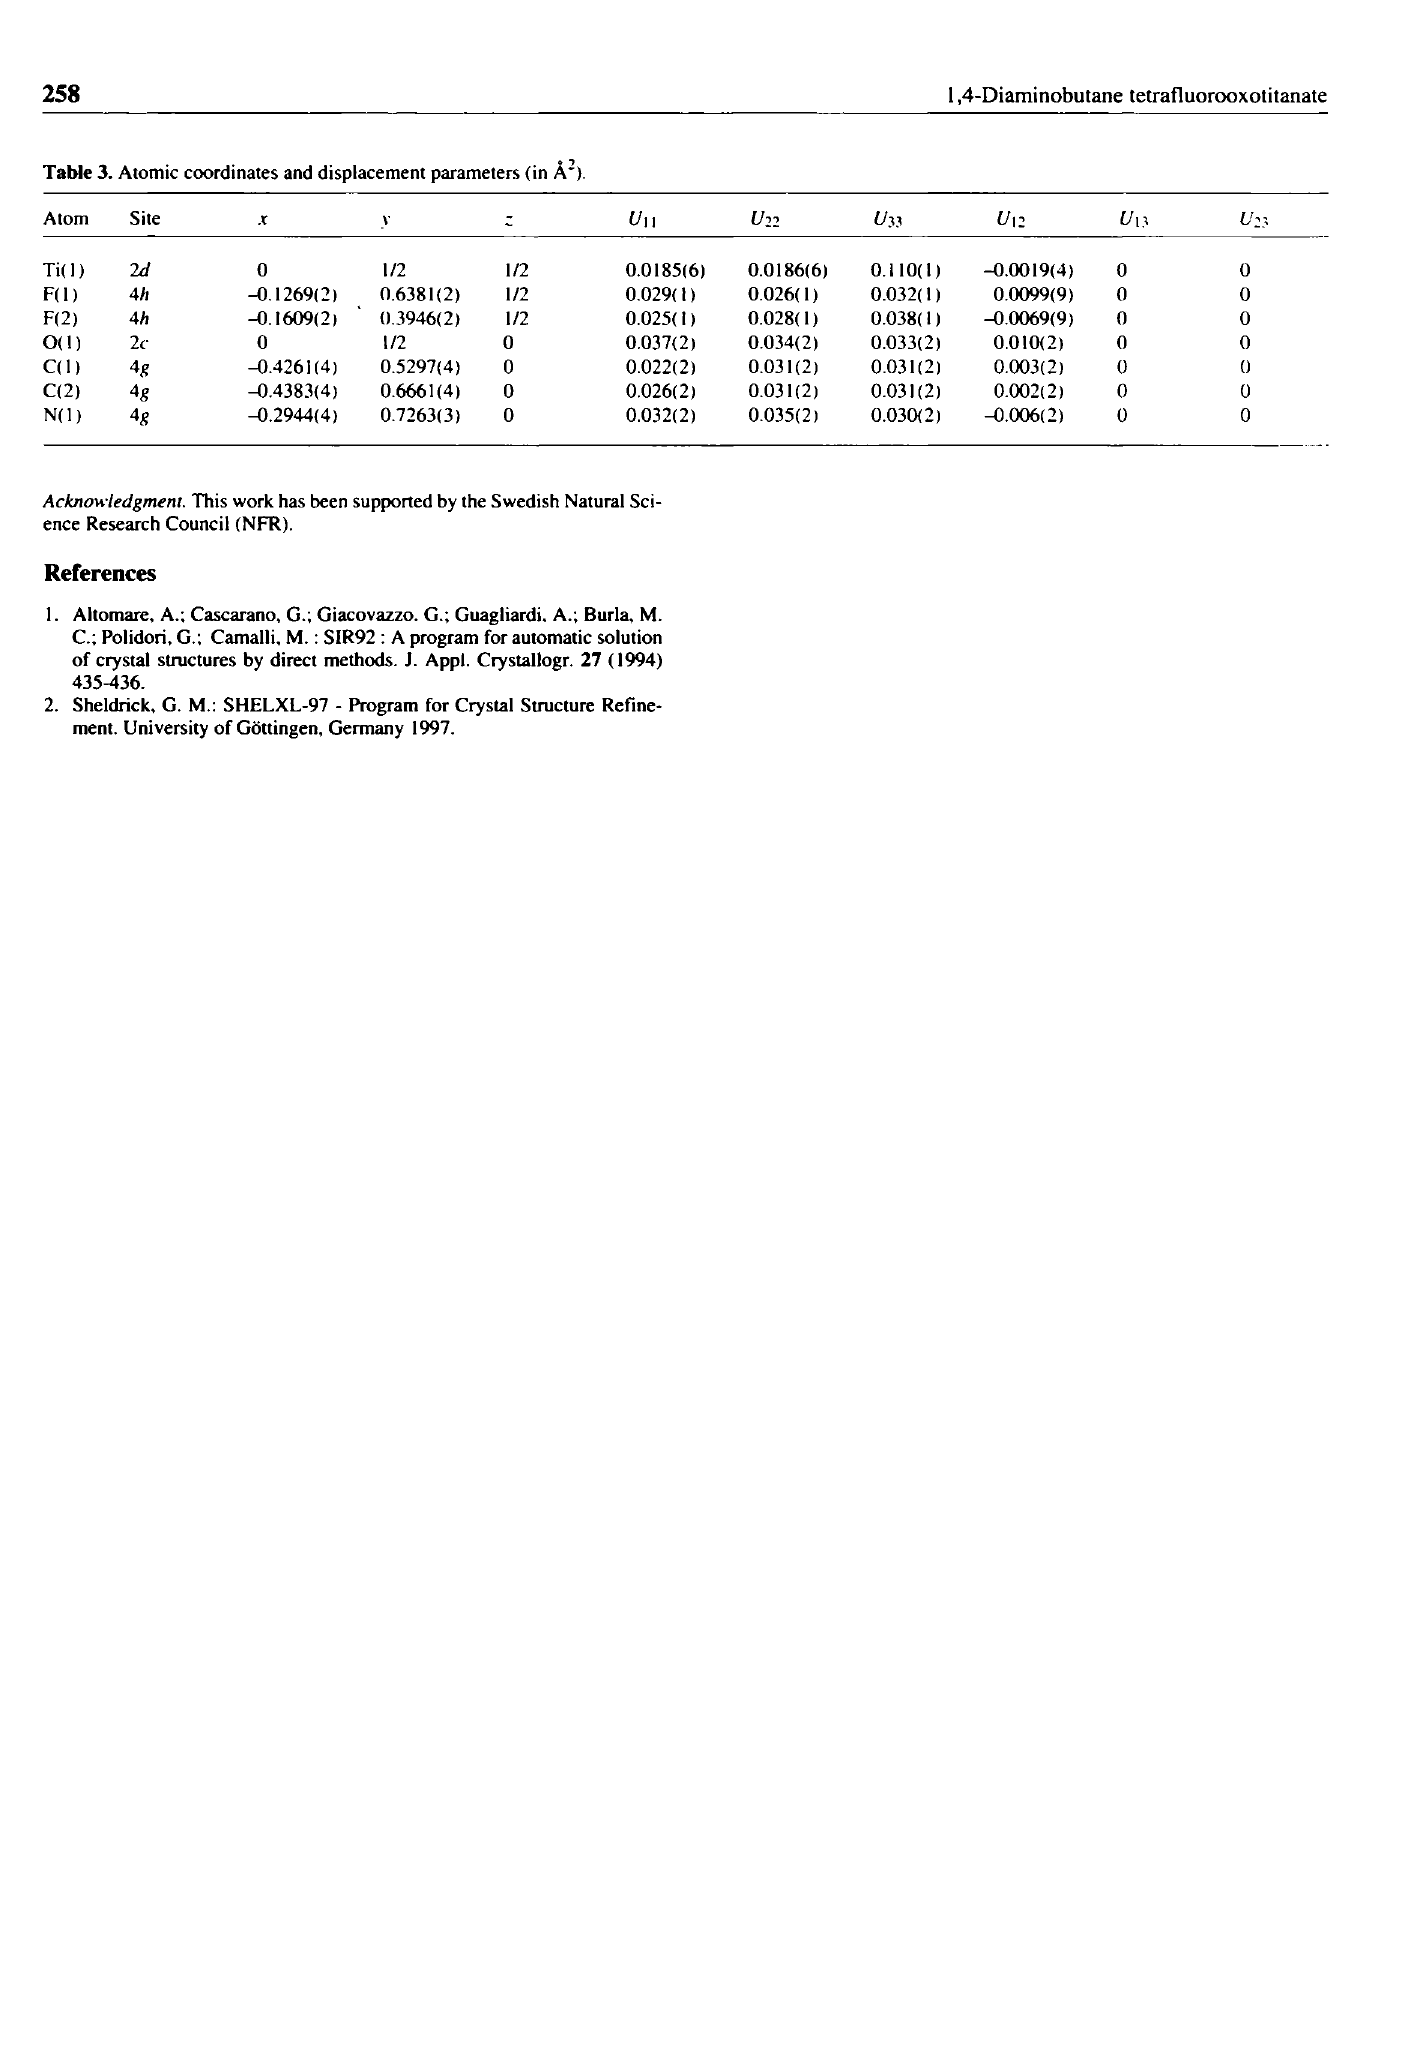
Table 3. Atomic coordinates and displacement parameters (in